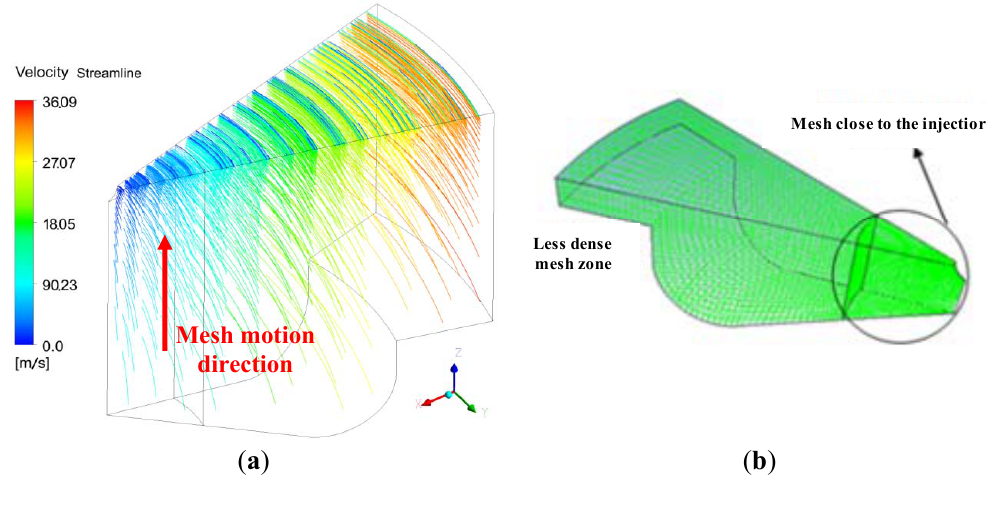
Figure 2. The computational mesh: ( a ) swirl initialization and ( b ) details of the structured